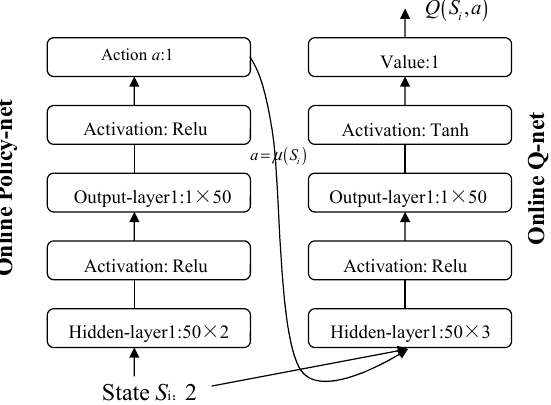
Figure 6. The neural network structure of online Q-net and online Policy-net.